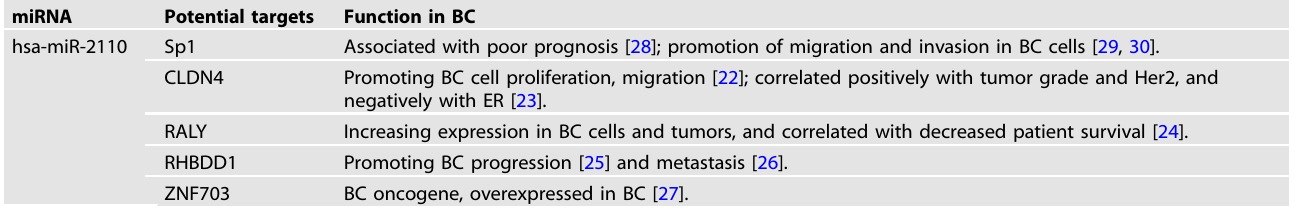
Table 2. Predicted target genes of miR-2110.